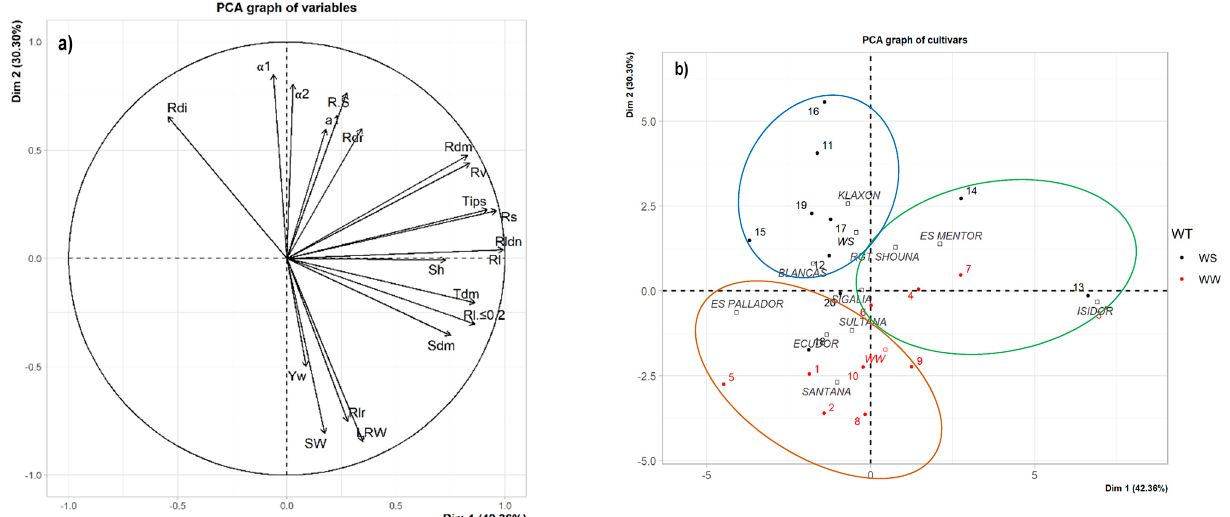
Figure 4. ( a ) Factor loadings for the variables measured on 10 soybean cultivars grown under well-watered “WW” and water-stressed “WS” conditions for the first two axes of the principal component analysis (PCA). Shoot dry matter (Sdm), root dry matter (Rdm), total dry matter (Tdm), root: shoot ratio (R.S), shoot length (Sh), total root length (Rl), root surface area (Rs), average root diameter (Rdi), root volume (Rv), root tips number (Tips), specific root surface (SW), root length density (Rldn), specific root length (LRW), length of roots with diameter ≤ 0.2 mm (Rl ≤ 0.2) root penetration rate in depth (Rdr), root lateral expansion rate (Rlr), root angle 1 ( α 1), root angle 2 ( α 2), distance from soil to longest lateral root insertion on taproot (a1) and plant water potential (Yw). ( b ) Projection of the different cultivars on the first two axes of the PCA. Number of individuals from 1 to 10 (in red) and from 11 to 20 (in black) represent cultivars under well-watered and water-stressed conditions, respectively. The green, blue and brown circles represent the three discriminated cultivars x soil moisture status groups based on the hierarchical clustering.